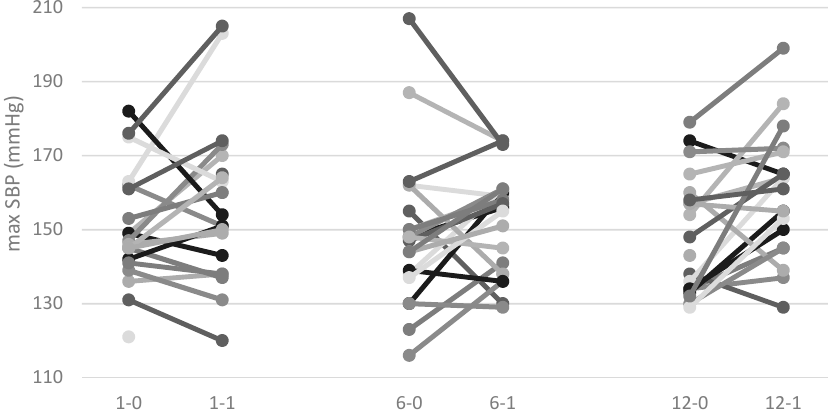
Figure 1. Changes in maximal systolic blood pressure. max SBP is maximal systolic blood pressure (BP), 1-0 is 24-hours (h) before first intravenous methylprednisolone (IVMP) infusion, 1-1 is 24-h after the beginning of first IVMP infusion, 6-0 is 24-h before sixth IVMP infusion, 6-1 is 24-h after the beginning of sixth IVMP infusion, 12-0 is 24-h before 12th IVMP infusion, and 12-1 is 24-h after the beginning of 12th IVMP infusion. The different colors of lines “grey, white, black…” define BP measurements in examined patients.